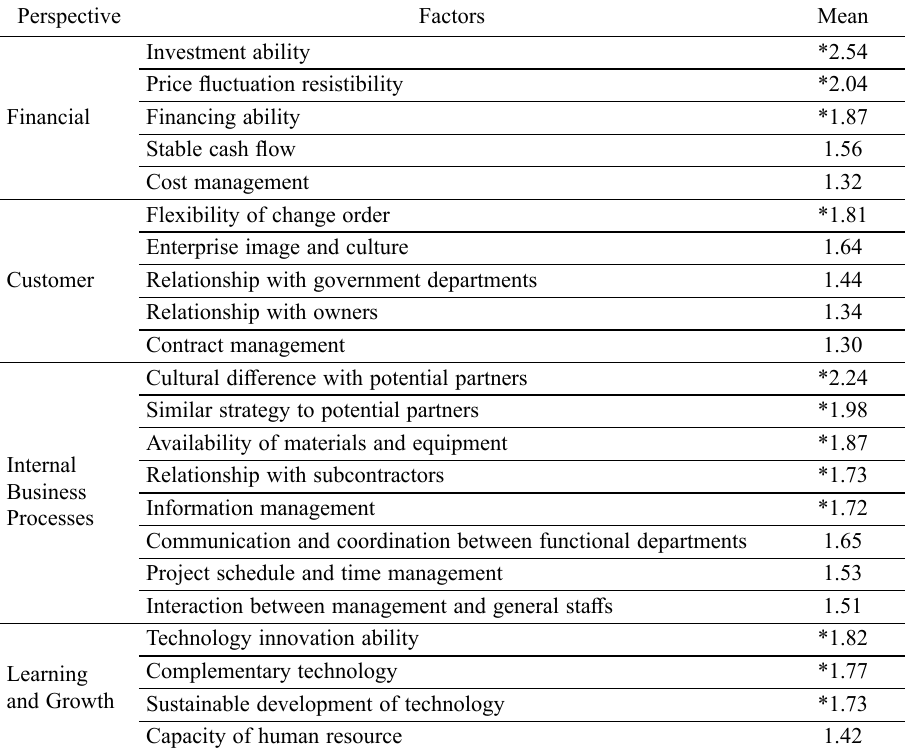
Table 1. Statistical results of the preliminary questionnaire